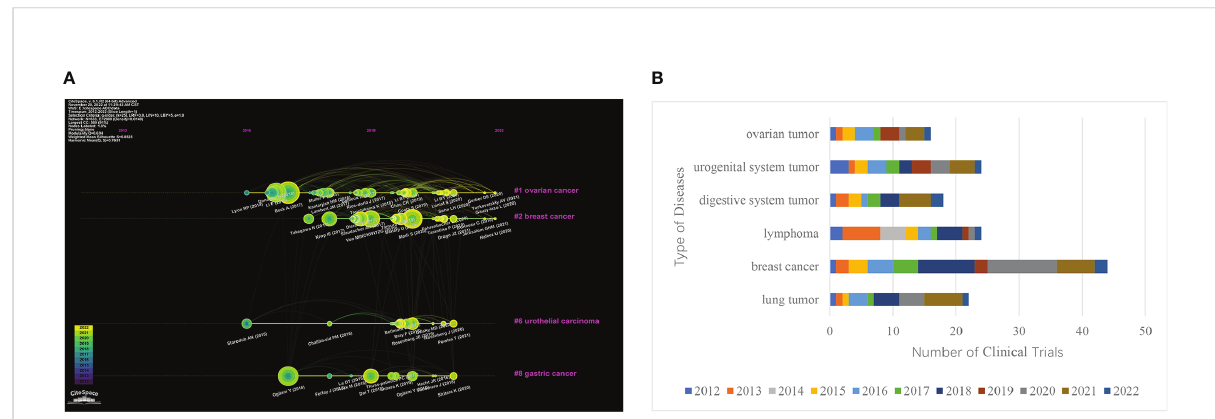
FIGURE 4 Major clinical indications for ADCs. (A) Clustering timeline of references related to ADCs research. (B) Bar chart of the clinical trials and disease type ranking of